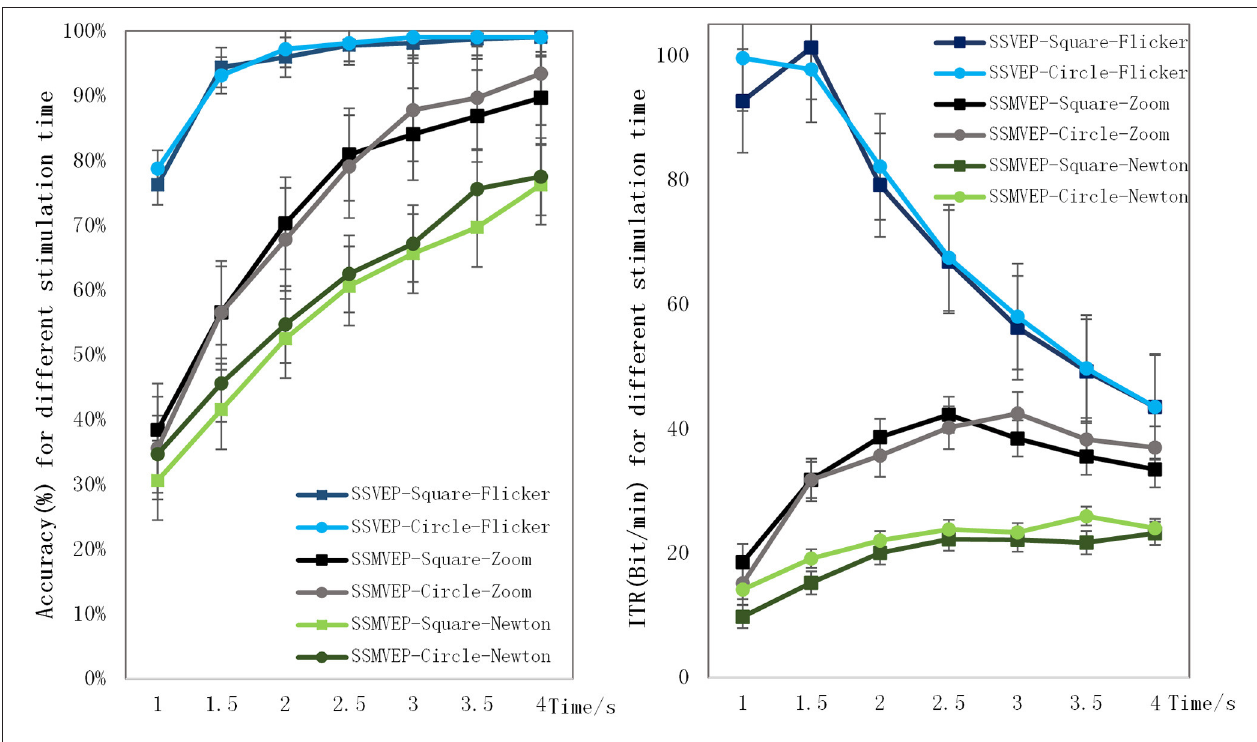
FIGURE 6 | Recognition accuracy and ITR for different stimulation durations.